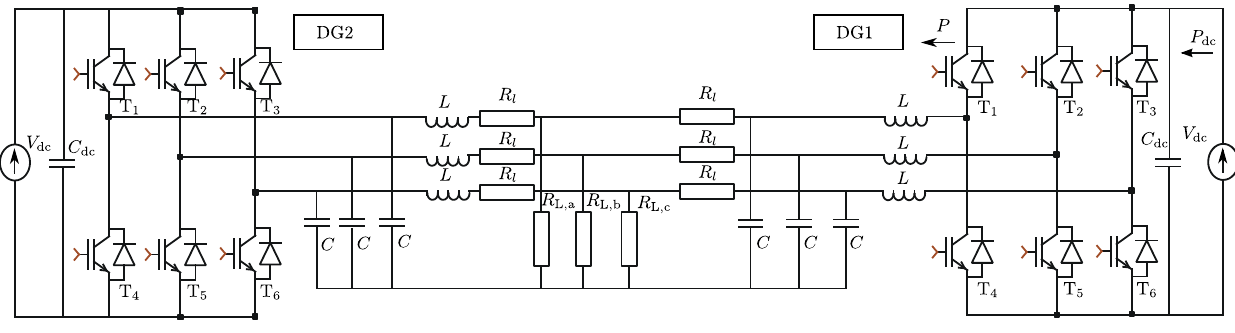
Figure 4. Islanded microgrid with two three-phase inverters.